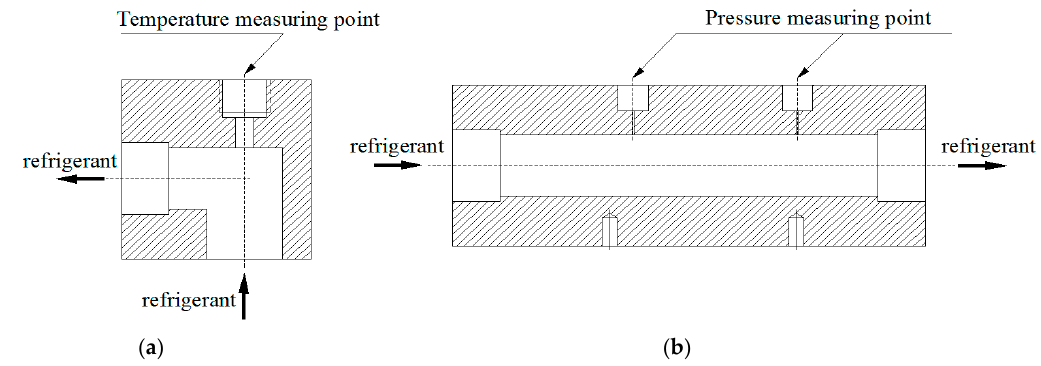
Figure 2. ( a ) The test section and ( b ) cross-sectional view of the micro-fin tube.